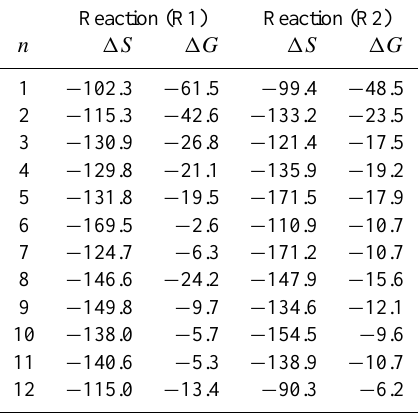
Table 1. Entropy and Gibbs free energy of Reactions (R1) and (R2) at standard conditions ( T = 298 . 15 K, p = 1 bar). Units are J/mol · K andkJ/mol. The values of 1 G are plotted in Fig. 1 as function of n .